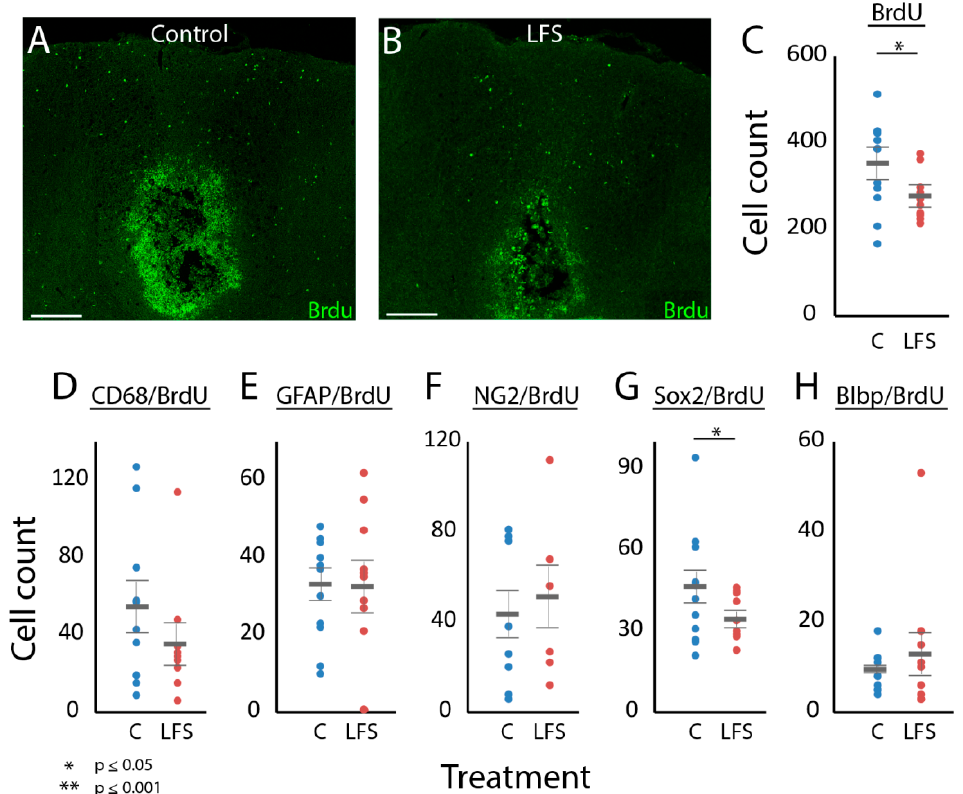
Figure 4. Effects of LFS of NRM on cellular proliferation at the lesion. Representative sections through DWM and GM of LFS-treated ( A ) and control ( B ) animals showing the expression of BrdU-positive cells surrounding the lesion cavity. The scatter plots compare cell counts of BrdU ( C ) and stains co-labeled with BrdU, namely CD68 ( D ), GFAP ( E ), NG2 ( F ), Sox2 ( G ), and Blbp ( H ), for animals in the control (blue) and LFS (red) groups. Only cell counts from DWM and GM are included. The thick horizontal gray bars show the mean of the counts and thin horizontal gray bars show standard error. Asterixis above the graphs denote statistical significance, which was tested for using bootstrap analyses. Scale bar for A and B is 200 µm. C, control; LFS, low-frequency stimulation.